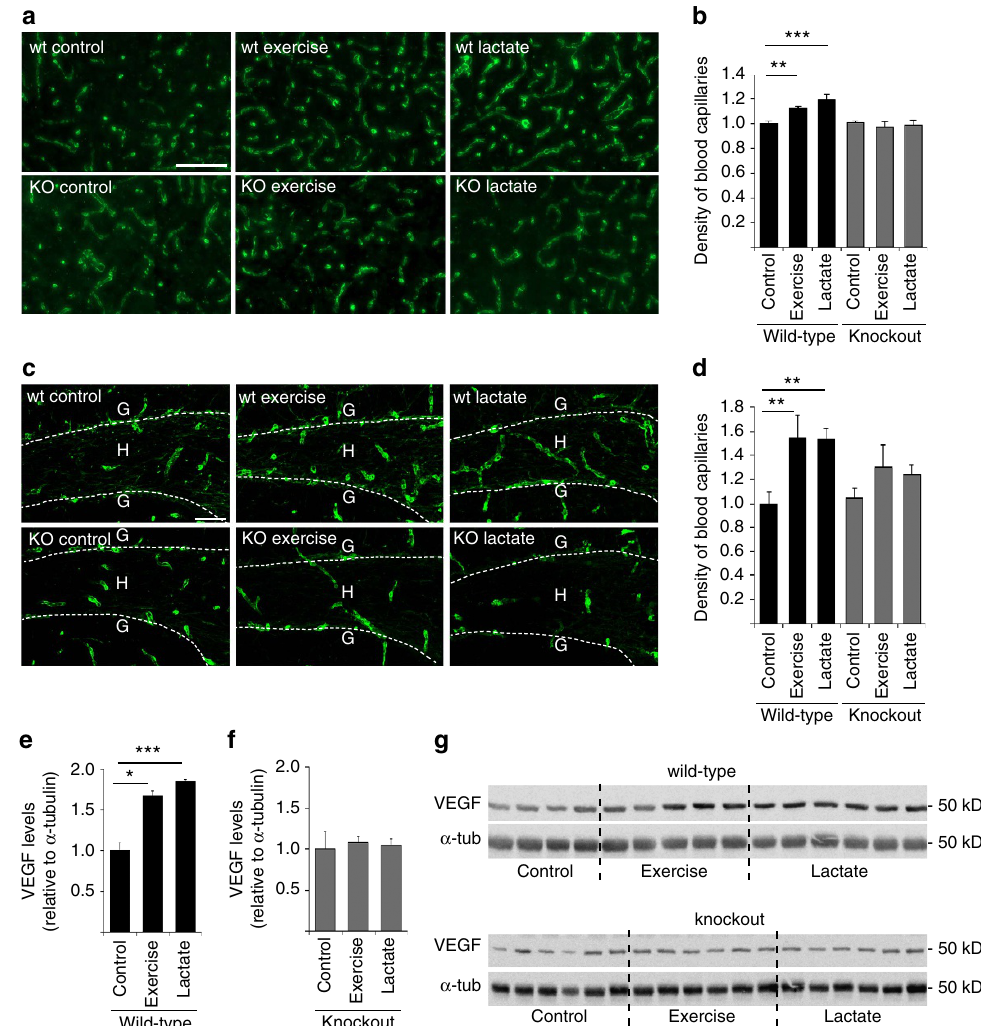
Figure 1 | HCAR1 regulates VEGFA and capillary density in response to exercise. ( a ) Collagen IV-labelled capillaries in the sensorimotor cortex grey matter of wild-type or Hcar1 knockout mice exposed to vehicle injections (control), treadmill exercise or lactate injections, 5 days a week for 7 consecutive weeks. Scale bar, 100 m m. ( b ) Capillary density (per cent of the total area, normalized to wild-type control) in the sensorimotor cortex. Mean ± s.e.m. of n ¼ 7 wild-type controls, seven wild-type exercise, six wild-type lactate, five knockout controls, four knockout exercise and six knockout lactate mice. Analysis of variance (ANOVA), P ¼ 0.001; Fisher’s least significant difference (LSD) post hoc test, ** P o 0.01; *** P o 0.001. ( c ) Collagen IV-labelled capillaries in the dentate gyrus (DG) of the hippocampus of wild-type or Hcar1 knockout mice treated as in a . Stippled line, the inner border of the granule cell layer (G), circumscribing the sampled area, hilus (H). Scale bar, 50 m m. ( d ) Capillary density (see b ) in the hilus. Mean ± s.e.m. of n mice ( n ¼ 4–7, as specified below for diameters). ANOVA, P ¼ 0.022; Fisher’s LSD post hoc test, ** P o 0.01. Capillary external diameters ( m m) in the same areas were unchanged (mean ± s.e.m. ( n )): wild-type control 5.8 ± 0.2 (6), wild-type exercise 5.7 ± 0.1 (7), wild-type lactate 5.7 ± 0.2 (6), knockout control 5.8 ± 0.3 (5), knockout exercise 6.0 ± 0.1 (4), knockout lactate 5.8 ± 0.2 (6). ANOVA, P ¼ 0.93. ( e ) Quantification of VEGFA in hippocampus of wild-type animals. Data are relative to a -tubulin ( a -tub), normalized to wild-type control, mean ± s.e.m. of n ¼ 4 wild-type control mice, five wild-type exercised mice and six mice treated with lactate, ANOVA, P ¼ 0.001; Dunnetts’s T3 post hoc test, * P o 0.05, *** P o 0.001. ( f ) Quantification of VEGFA in hippocampus of knockout animals presented as in e . n ¼ 6 mice per group. ANOVA, P ¼ 0.88. ( g ) Western blots of VEGFA underlying e , f (uncropped scans shown in Supplementary Fig.